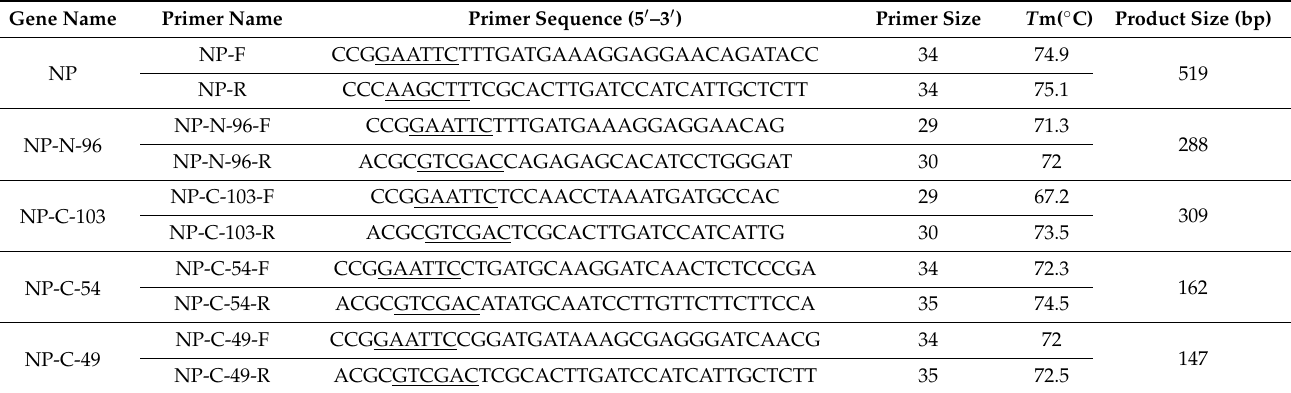
Table 1. Primers of the truncated NP gene for PCR